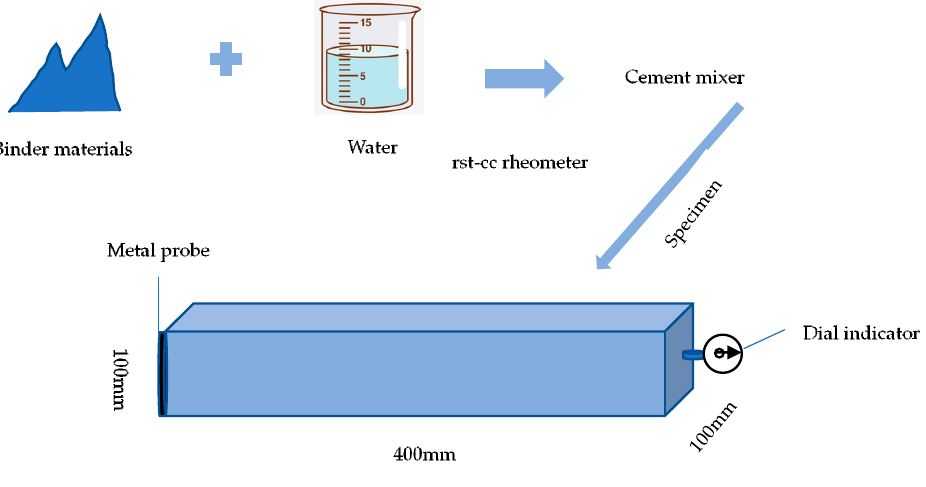
Figure 2. Measurement of the expansion rate of specimens.